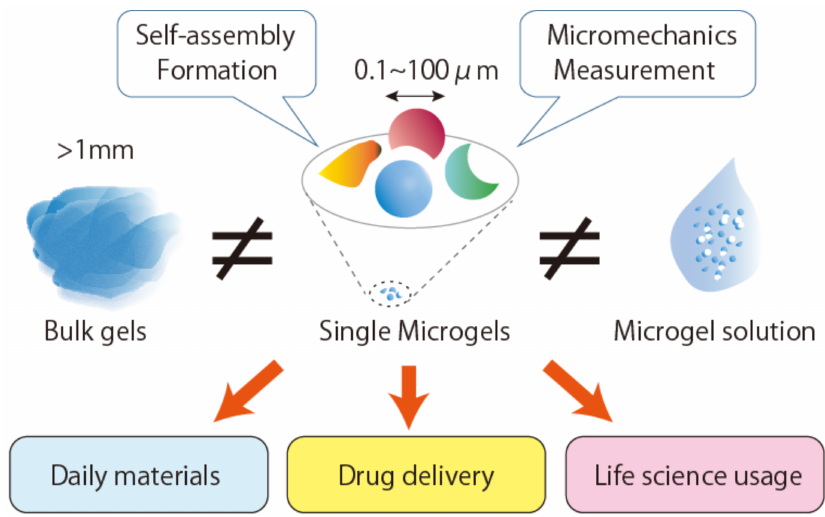
Figure 1. Schematic illustration of nonspherical single microgels exhibiting unique properties and